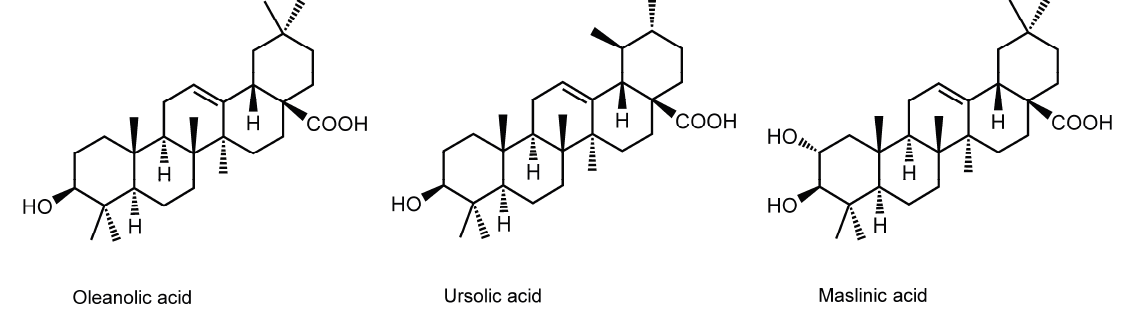
Figure 10. Structures of membrane-interactive pentacyclic triterpene